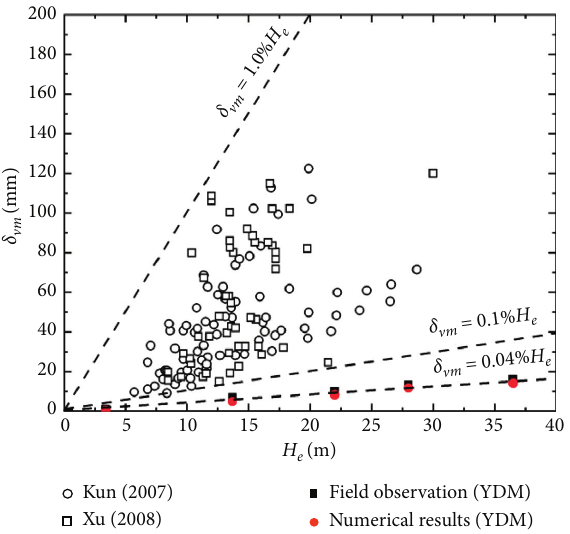
Figure 9: He versus δ